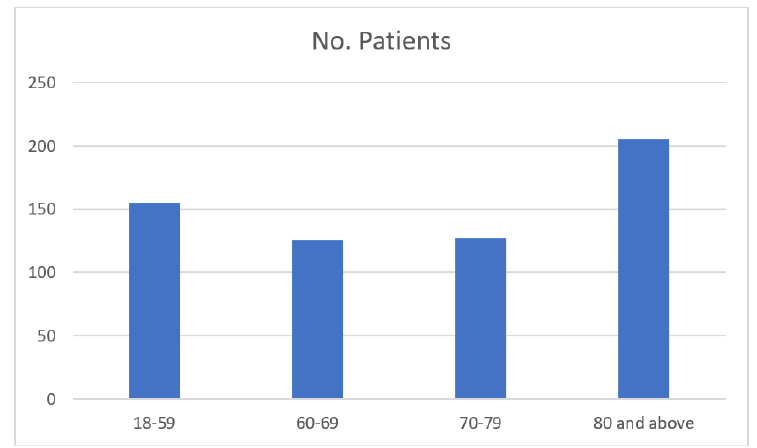
Figure 2. Surgeries in each age group.